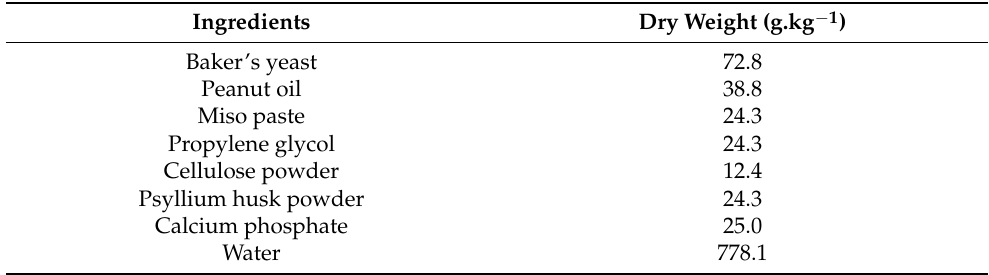
Table 1. Composition of synthetic human feces prepared for the adsorption of nutrients from human